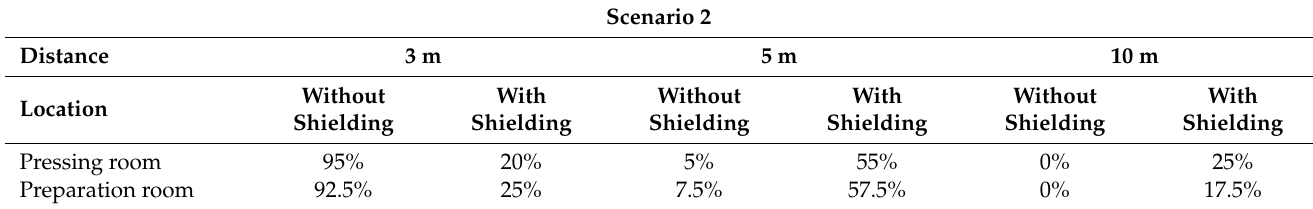
Table 3. Scenario 2: Success rate of determining distance from gateways.